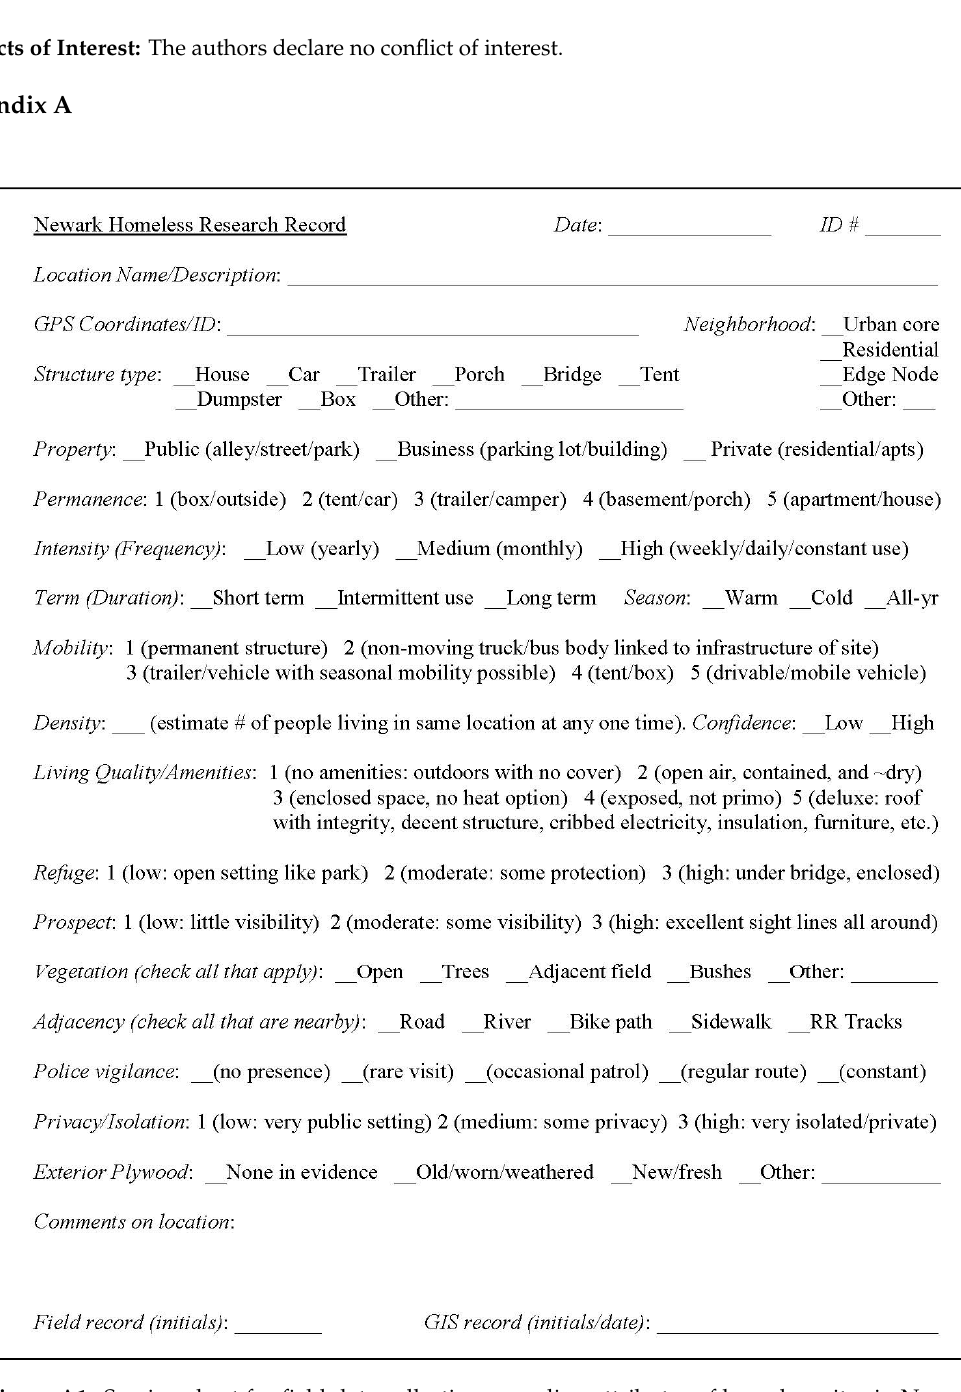
Figure A1. Scoring sheet for field data collection regarding attributes of homeless sites in Newark, Ohio. Note that the attribute survey was designed to be applicable to many types of informal homeless sites, therefore some categories (e.g., structure type, permanence, mobility) were not utilized in the current data set focused on abandoned houses.